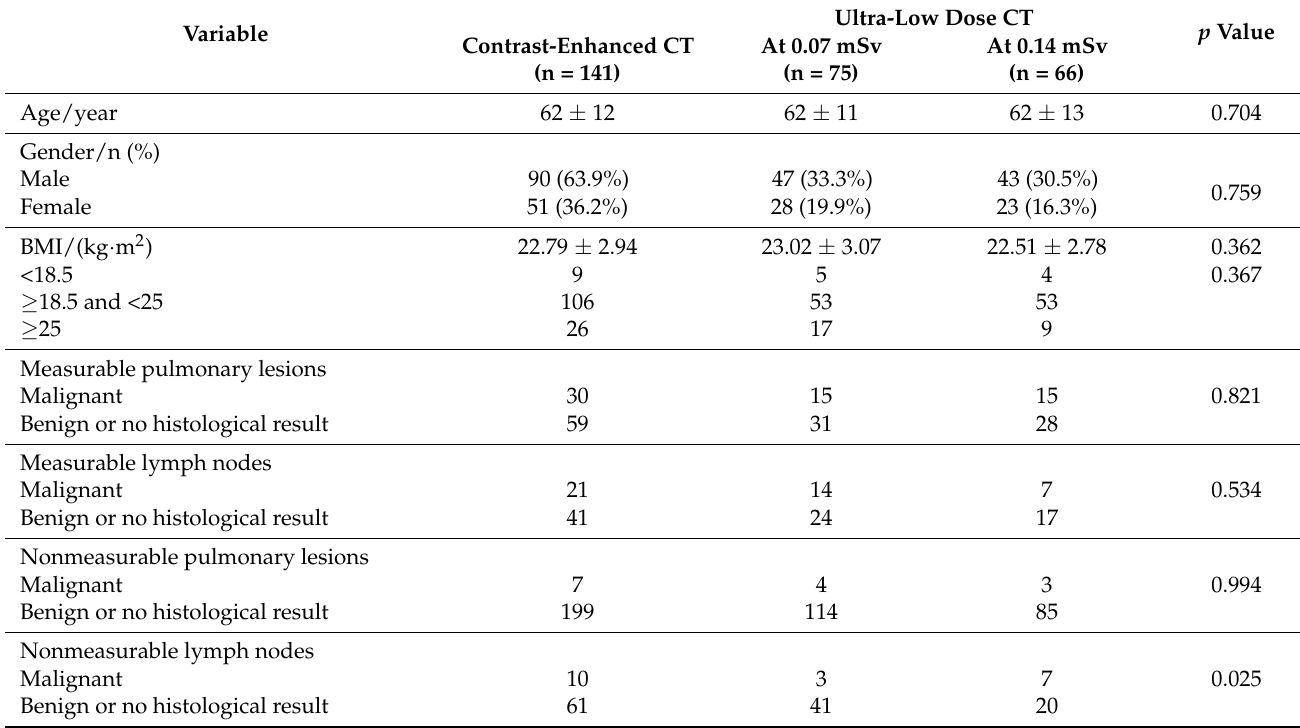
Table 1. Basic patient